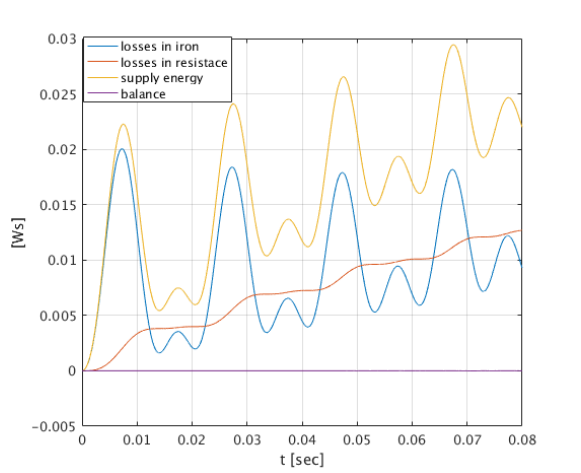
Figure 13. The supply energy waveform, energy losses in iron, energy of losses of resistance, and zeroing energy balance for the angular frequencies ω = 3141.6 rad